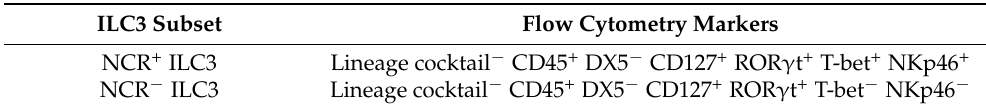
Table 1. ILC3 subsets defined by flow cytometry analysis. ILC3